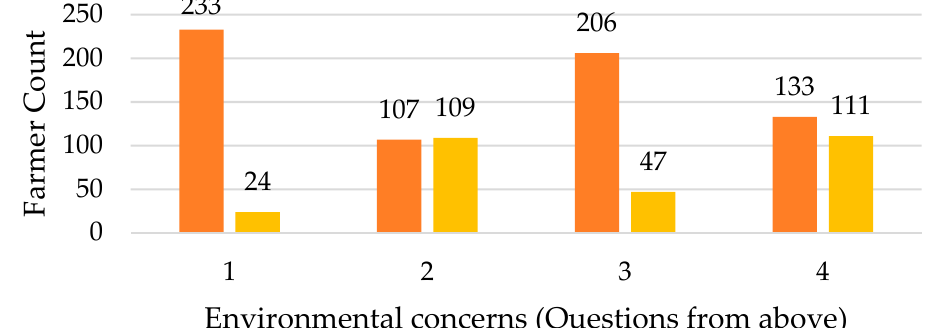
Figure 5. Respondent ′ s answers to environmental questions (Yes or No).